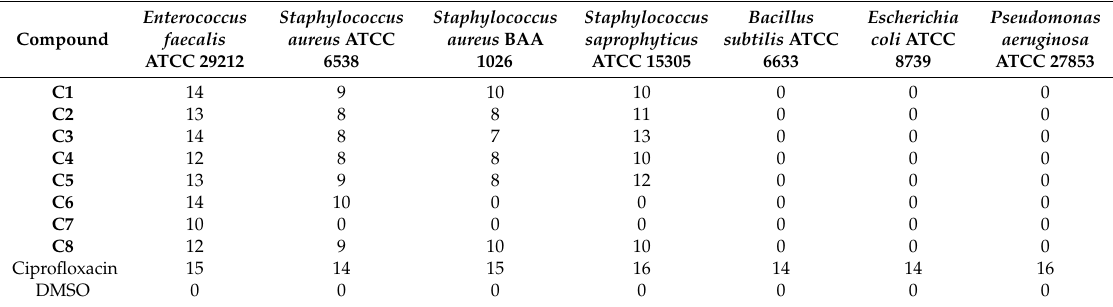
Table 1. The antimicrobial activity of the tested compounds expressed as microbial growth inhibition diameters